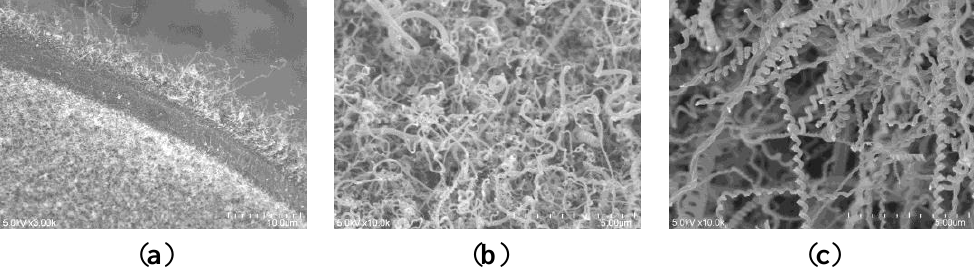
Figure 3. SEM micrographs of carbon deposits: ( a ) cross-sectional view of CNC and carbon layers; ( b ) the surface of a low-purity CNC layer; and ( c ) the surface of a high-purity CNC layer. In ( a ), the relatively dark area shows a carbon layer that does not contain CNCs; many